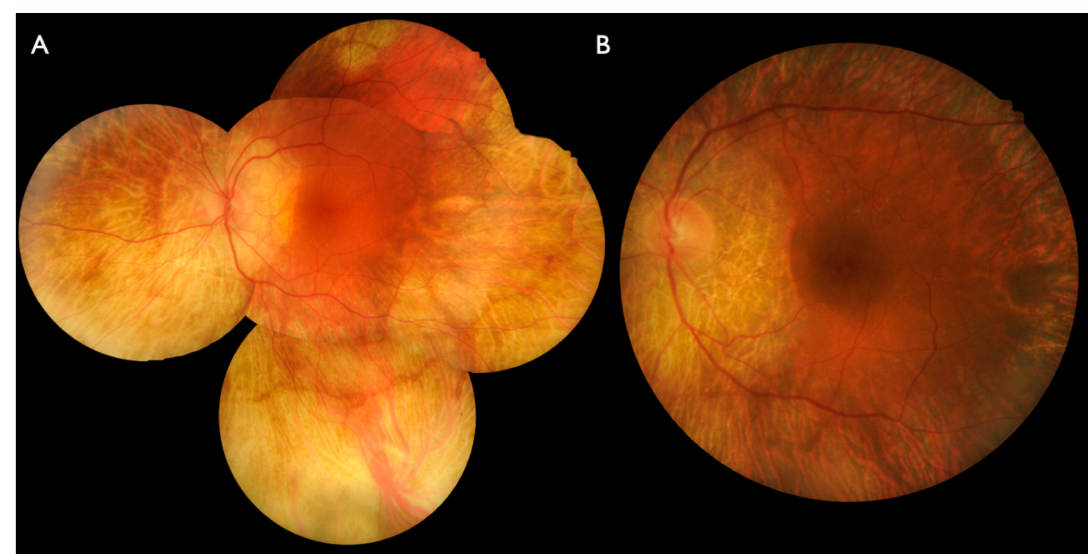
Figure 3. Fundus photography in family ADRP 386 in patient IV:2 at 53 years of age ( A ) and patient IV:3 at 56 years of age ( B ). Peripapillary atrophy is present in both patients. Peripheral confluent atrophic areas have approached to the macular area except from superior in patient IV:2, whereas circular atrophy up to the vascular arcades is present in patient IV:3.